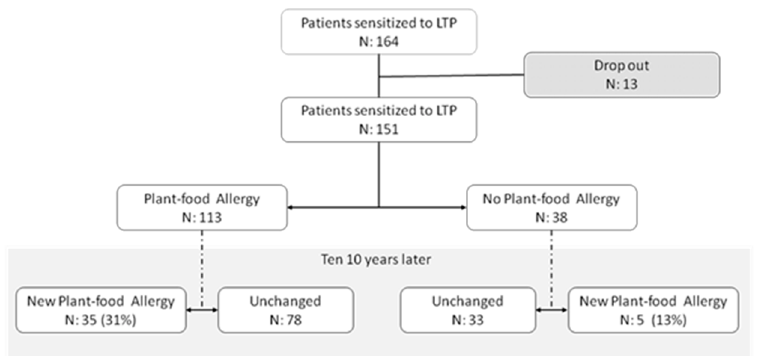
Figure 1. Study flow chart.